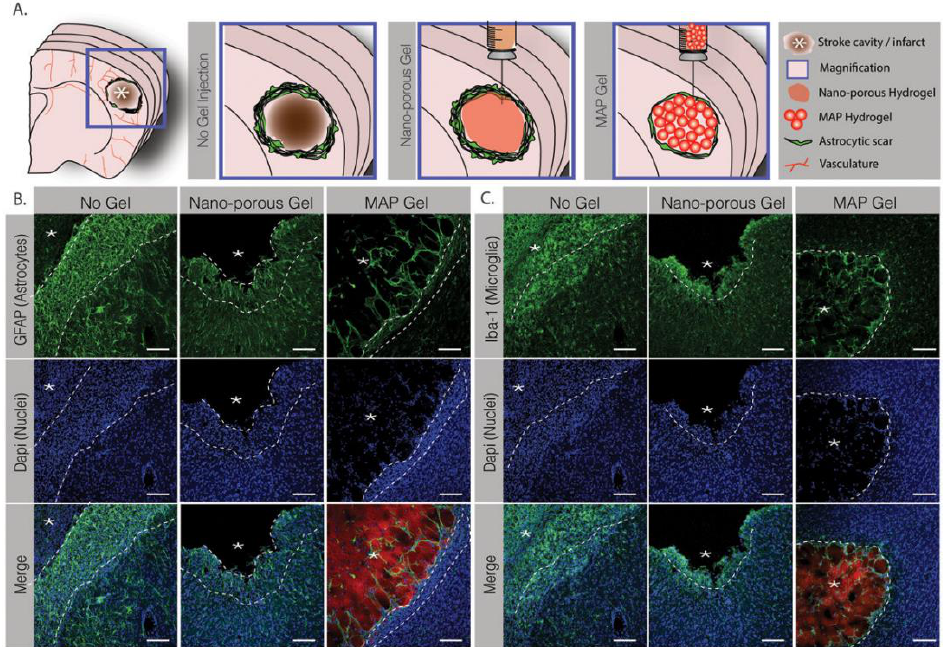
Figure 3. ( A ) Schematic illustration of a coronal mouse brain section, the magnified schematics show the No Gel, nanoporous and MAP hydrogel injection conditions. ( B , C ) Fluorescent images of GFAP and IBA- 1 staining showing poststroke astrocytic and microglial response (scale bar: 100 μm), “*” represents stroke cavity as illustrated in ( A ). Reproduced with permission from [57]. Copyright 2011, Elsevier.